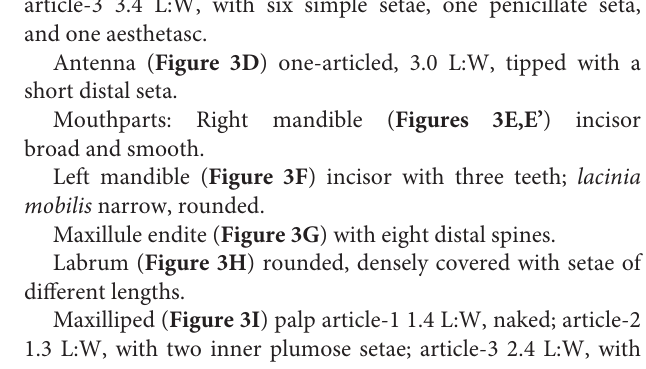
Description of neuter: Body from the holotype (ICUL1786), appendages from the paratype (ICUL10315). BL = 3.4 mm.